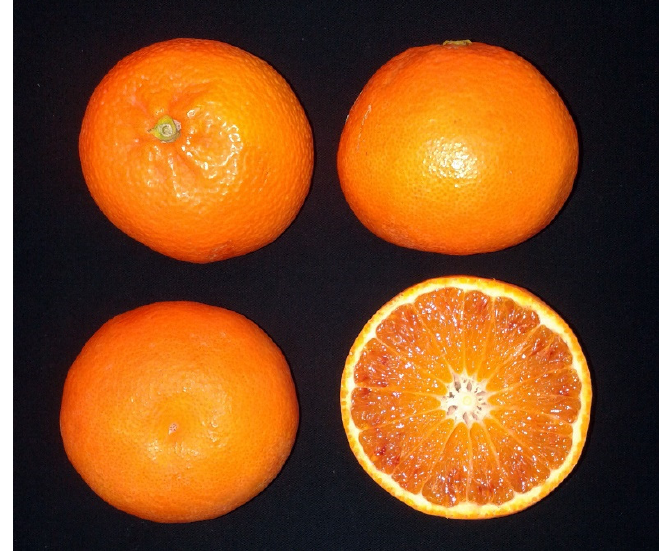
Figure 1. Fruits of Mandared ( Citrus clementina 2 x × Citrus sinensis 4 x).